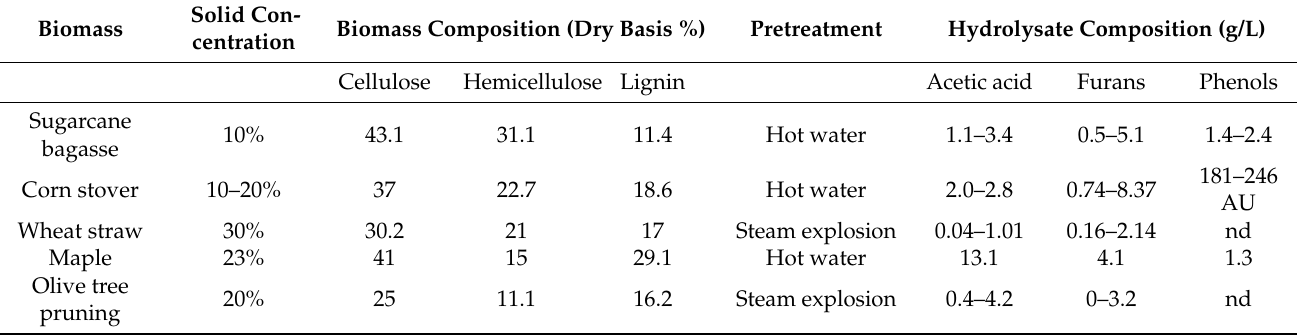
Table 3. Composition of different lignocellulosic biomasses and